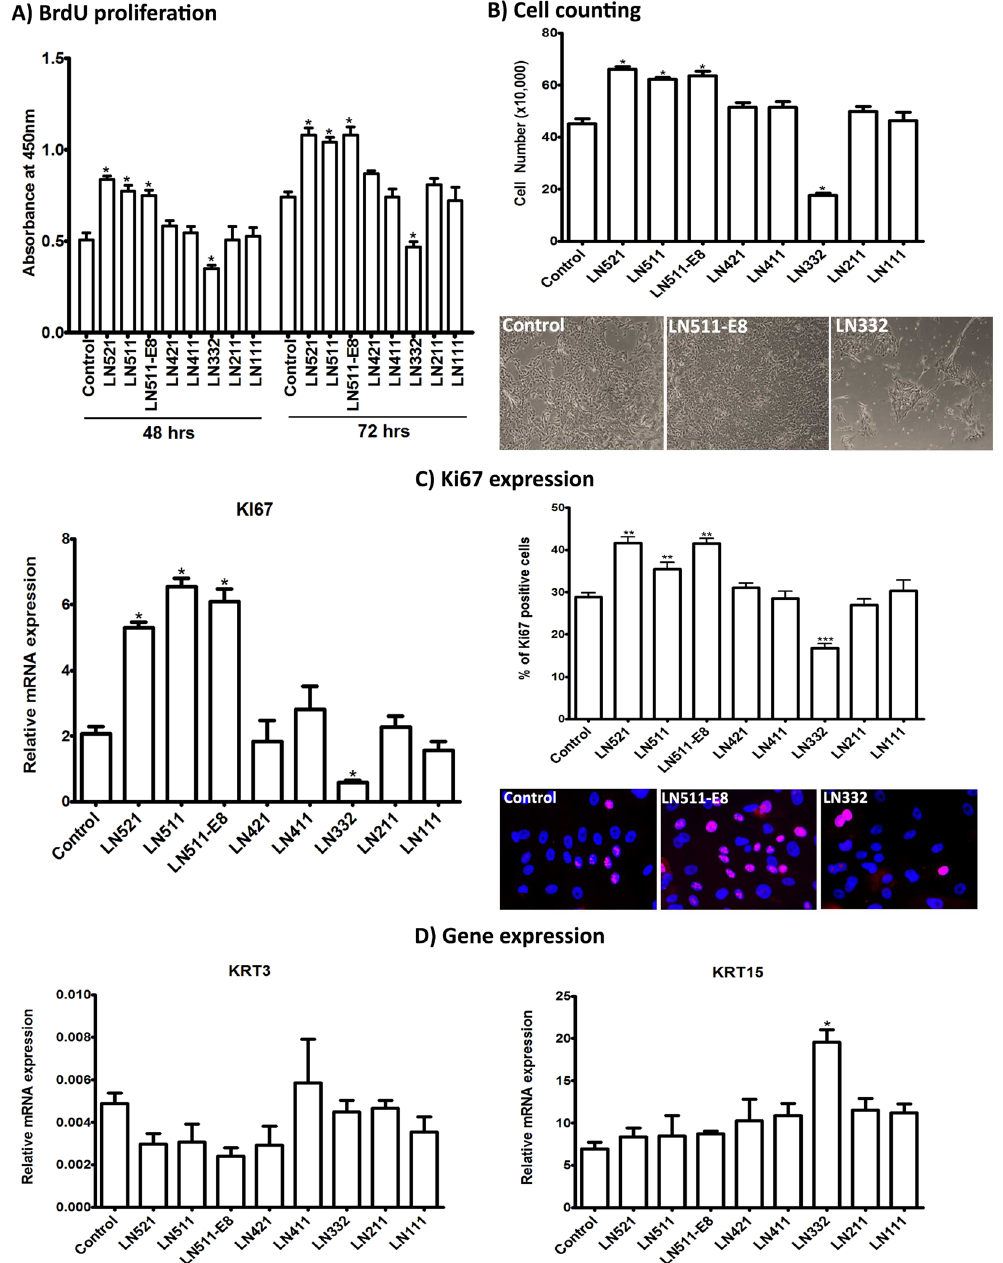
Figure 4. Effect of laminin isoforms on limbal progenitor cell proliferation and differentiation. ( A ) The effect of laminin (LN) isoforms on cell proliferation was tested by seeding limbal epithelial progenitor cells (LEPC) at a density of 15,000 cells/cm 2 and spectrophotometric measurement of BrdU incorporation 48 and 72 hours after incubation. Data are expressed as means ± SEM (n = 5). ( B ) The effect of LN isoforms on LEPC proliferation was also analyzed by cell counting using CASY technology 7 days after seeding (15,000 cells/cm 2 ); phase contrast images show LEPC cultured on tissue culture-treated plastic (control), LN-511-E8 and LN-332 before trypsinization for counting. Data are expressed as means ± SEM (n = 3). ( C ) The effect of LN isoforms on LEPC proliferation was additionally analyzed by Ki-67 expression on the mRNA level (left) and on the protein level (right). Ki-67 (KI67) mRNA levels were assessed by quantitative real-time polymerase chain reaction (qRT- PCR) primer assays, and data are expressed as means (2 −Δ CT × 1,000) ± SEM ( n = 5). Ki-67 protein levels were monitored by counting the number of Ki-67-positive cell nuclei (magenta) and nuclei counterstained with DAPI (blue) using Cell F program (magnification × 200). Percentages (%) of positive cells are expressed as means ± SEM (n = 3). ( D ) The effect of LN isoforms on LEPC differentiation was analyzed by qRT-PCR primer assays of KRT3 and KRT15 expression levels. Data are expressed as means (2 −Δ CT × 1,000) ± SEM ( n = 5); * p < 0.05; ** p < 0.01; *** p < 0.001; Mann-Whitney U